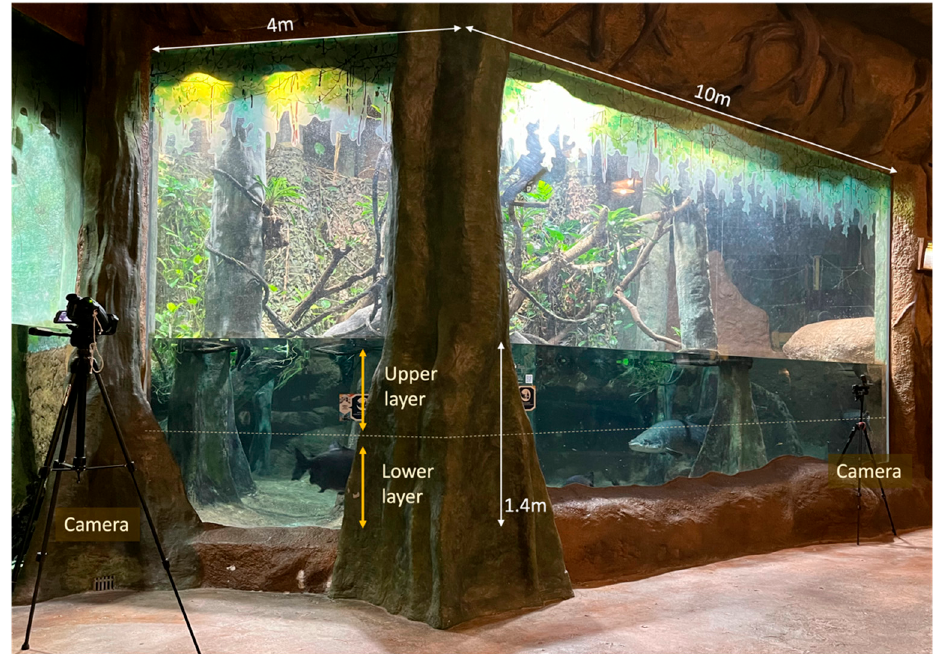
Figure 1. The research setup at the habitat (exhibition tank only) of the three Arapaima gigas , the dashed line indicates the border between the upper and lower layer of the water